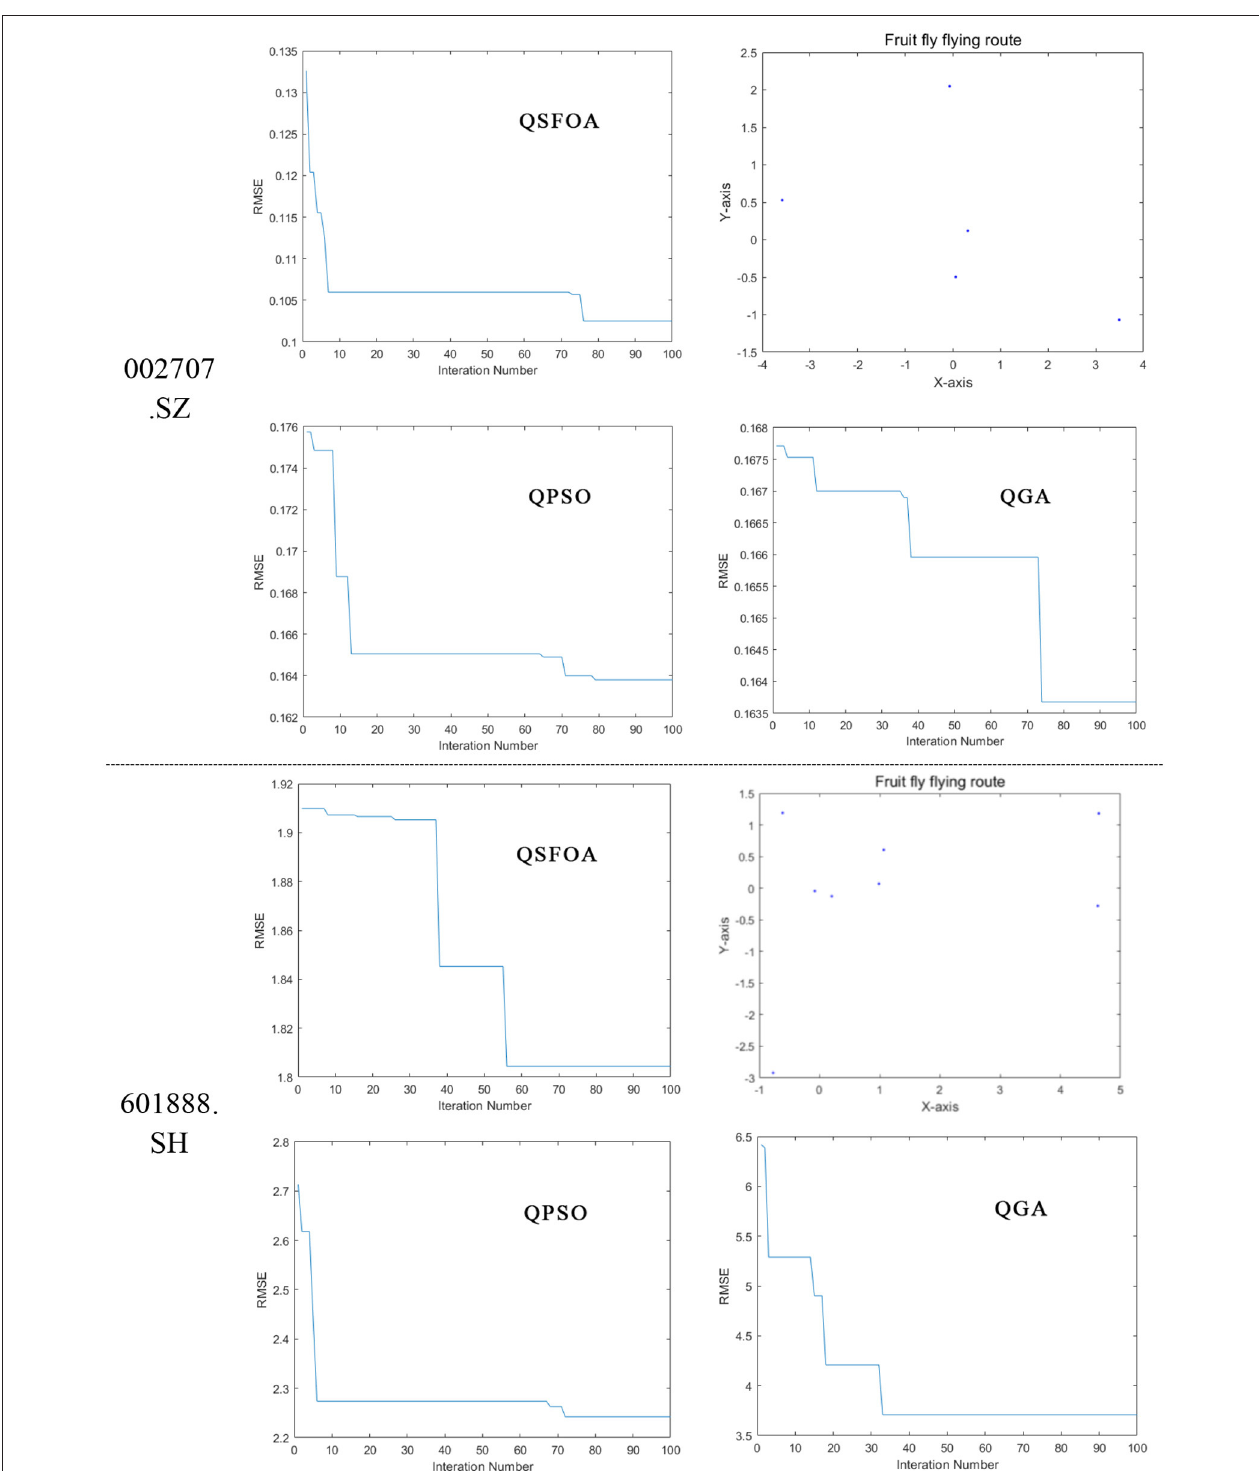
FIGURE 4 | Trend chart of RMSE’s iterative decline and fruit fly flying route.